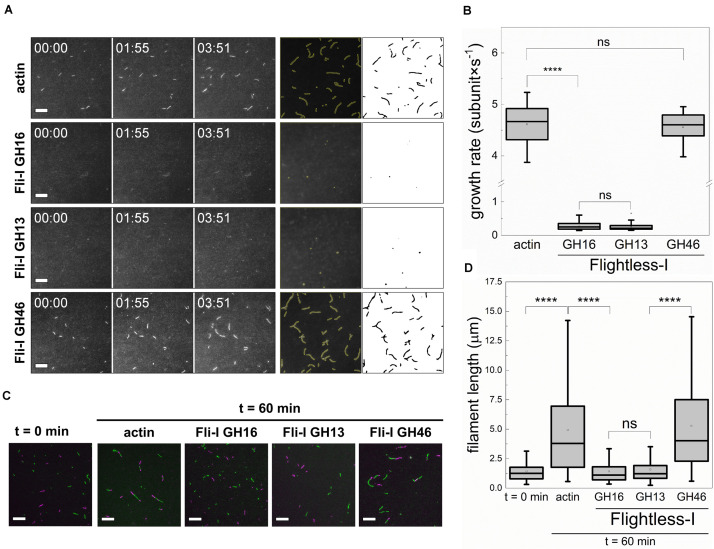
The gelsolin homology domains of Flightless-I inhibit actin filament growth by barbed end capping. (A) Left panels: Representative montages of actin assembly followed by TIRFM in the absence or presence of GST-Fli-I. Right panels: Representative skeletonized TIRFM images used for analysis showing the field of view of a 66 × 66 μm2 region in the absence or presence of GST-Fli-I. Conditions: [actin] = 0.5 μM (10% Alexa488NHS labeled), [Fli-I GST-GH16] = 10 nM, [Fli-I GST-GH13] = 10 nM, [Fli-I GST-GH46] = 100 nM. Scale bar = 10 μm, time = min:s. (B) Filament growth rate from G-actin in the absence or presence of different GST-Fli-I constructs derived from time-lapse TIRFM images shown on (A), n = 20–60. (C) Representative montage of actin filament end-to-end annealing followed by TIRFM in the absence or presence of different GST-Fli-I constructs. The t = 0 min corresponds to the initial fragmentation of filaments, while t = 60 min indicates the time interval after fragmentation. Conditions: [actin] = 0.5 μM (10% Alexa488NHS and 10% Alexa568NHS labeled), [GST-Fli-I] = 120 nM. Scale bar = 10 μm. (D) Filament length at t = 0 min and 60 min in the absence or presence of GST-Fli-I, derived from TIRFM images shown on (C), nsamples = 3–9, nFilaments = 136–174. ****p < 0.0001.